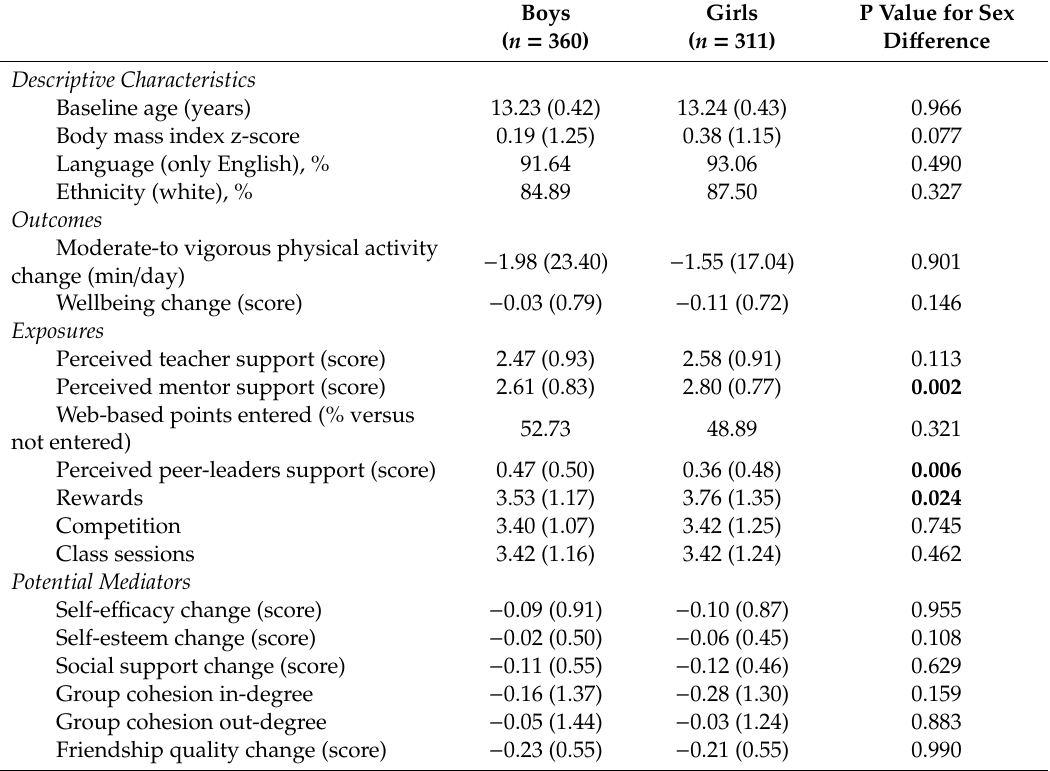
Table 2. Descriptive characteristics participants included in analyses.